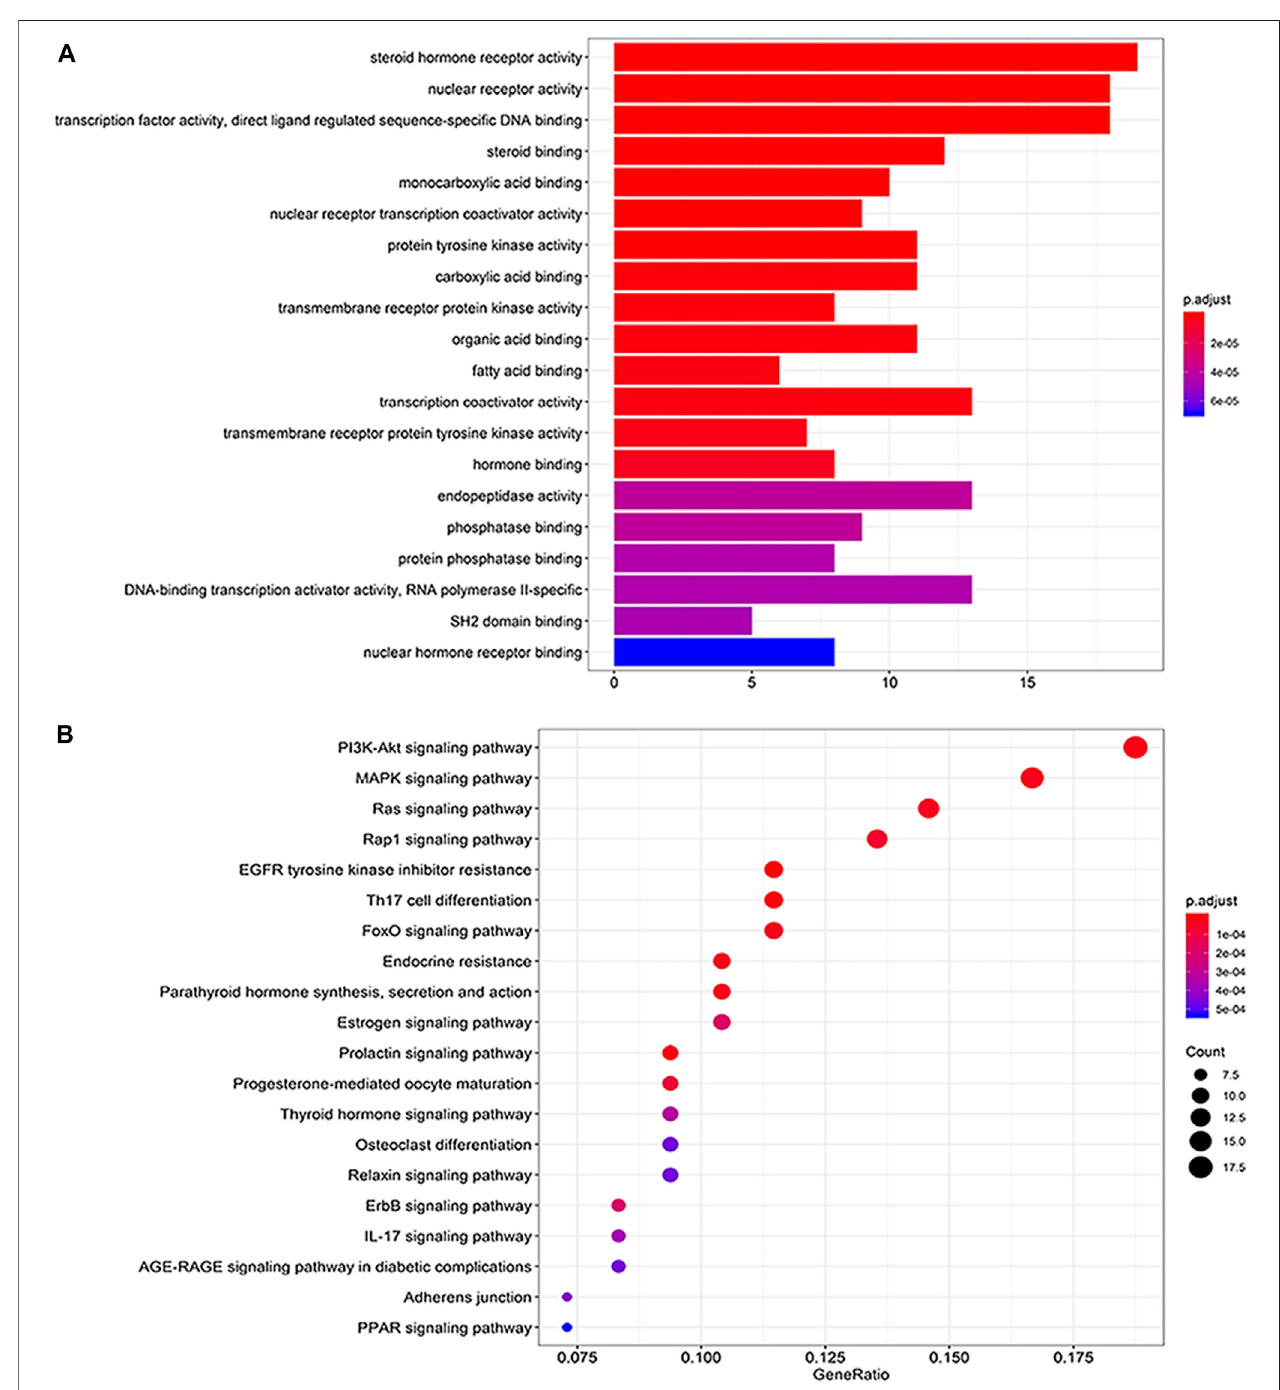
FIGURE3| Functionalanalysisofcandidatetargets. (A) Top20ofbiologicalprocessenrichment.Resultsshowedthatthecandidatetargetsinvolvedinavarietyof biological processes, such as steroid hormone receptor activity, nuclear receptor activity, transcription factor activity, director ligand regulated sequence-speci fi c binding. (B) Top 20 of pathway enrichment. Molecular signaling pathways of XTN were highlighted, such as PI3K-AKt signaling pathway, MAPK signaling pathway, Ras signaling pathway, Rap1 signaling pathway.